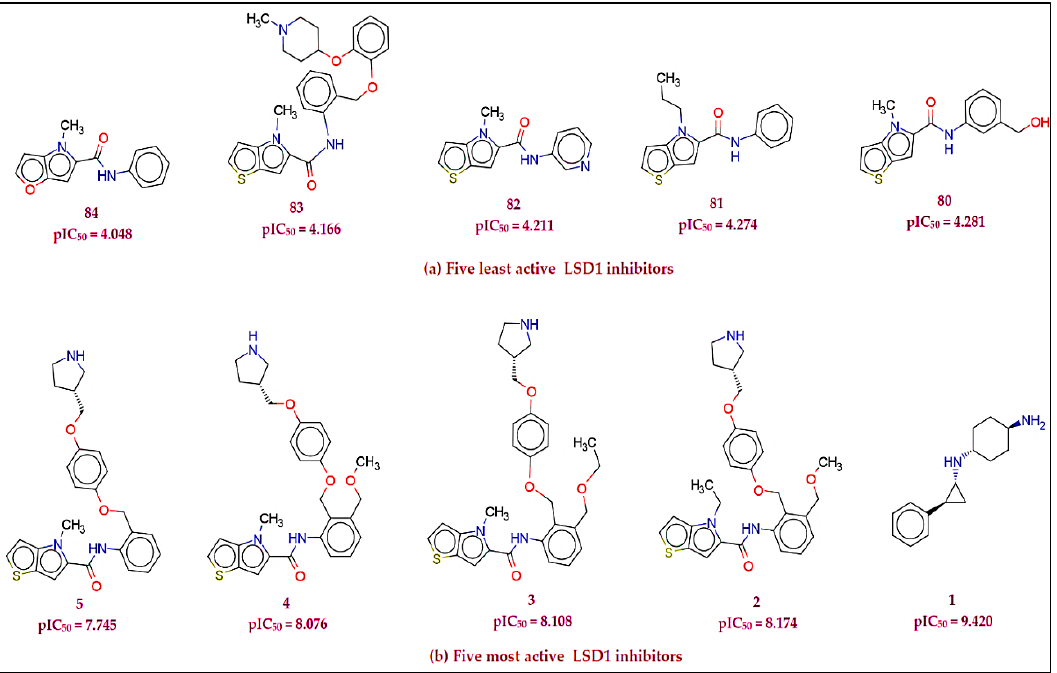
Figure 25. Representative ( a ) five least active and ( b ) five most active LSD1 inhibitors from the selected data set.